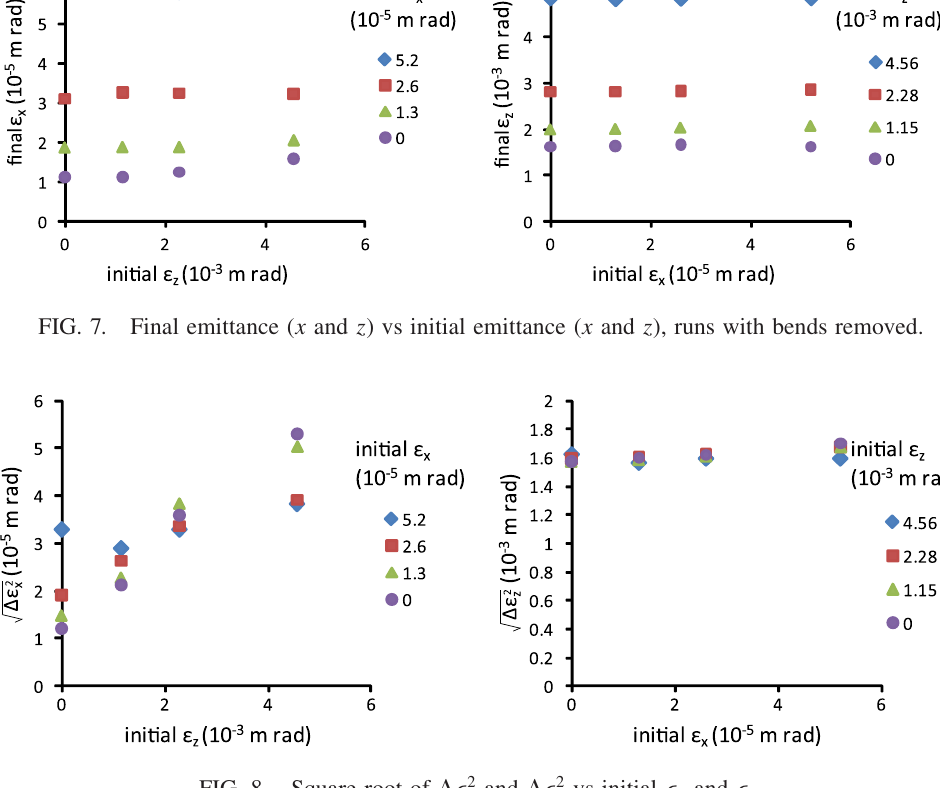
and (cid:1) (cid:1) 2 x